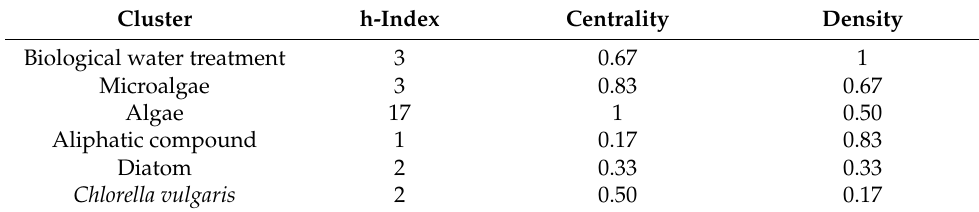
Figure 7. Strategic diagram for the second period (2006–2010). Table 2. The measure for themes of the second period